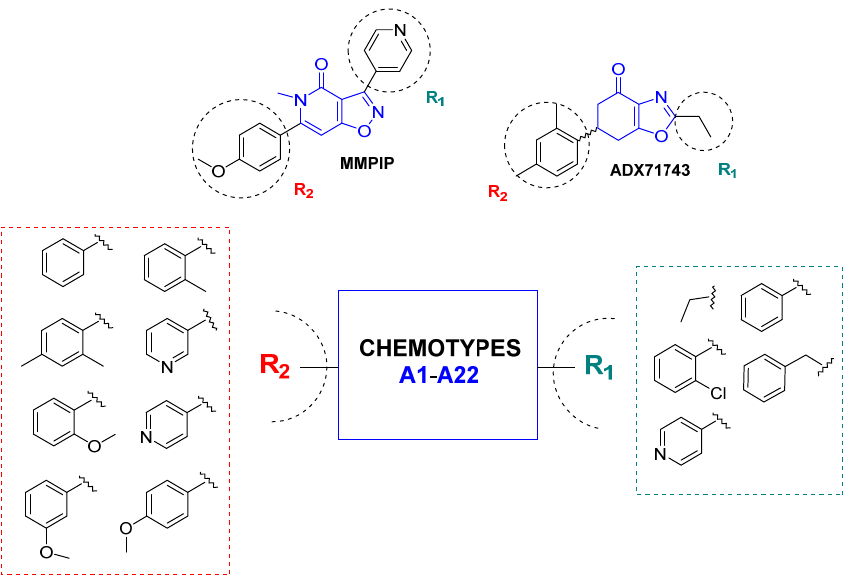
Figure 4. Terminal moieties (R 1 and R 2 ) introduced to designed chemotypes A1 – A22 (shown in the Supplementary Materials, summarized in Tables S1 and S2) via analogy to reference tool compounds MMPIP and ADX71743.